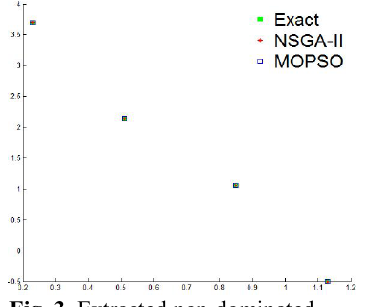
Fig. 5. Extracted non-dominated solutions by different approaches for permutation problem with 6